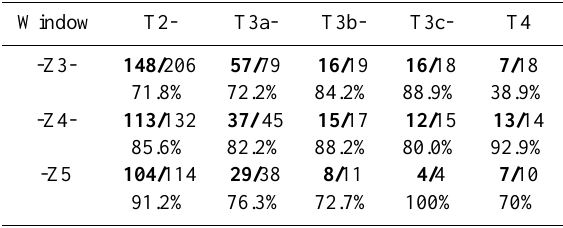
Table 2. Number (in bold) of upward moving wave packets in each window identified to be atmospheric gravity waves by dispersion equation. The number under the slash represents the number of wave packets being measured in each respective window, and the percentage of the originally measured wave packets to be identified as gravity wave packets was listed under the respective numbers. The events were obtained from winter data set. The content of win- dow T3bZ4 was displayed in the box of 3rd row–4th